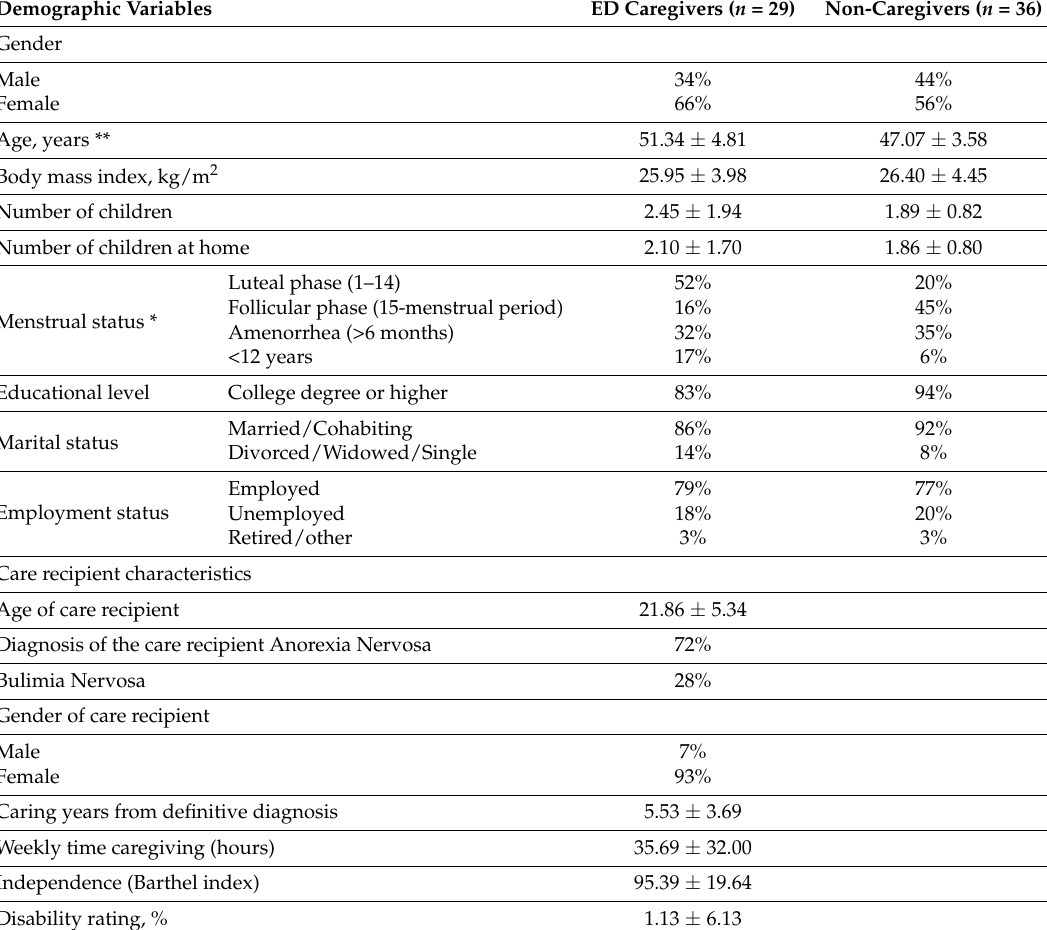
Table 1. Mean ± SD of age and body mass index and demographic variables for caregivers